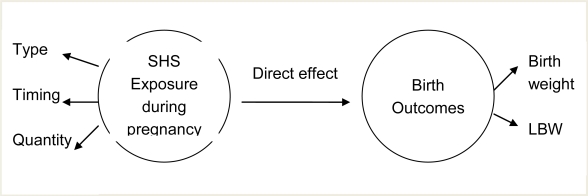
Study framework.